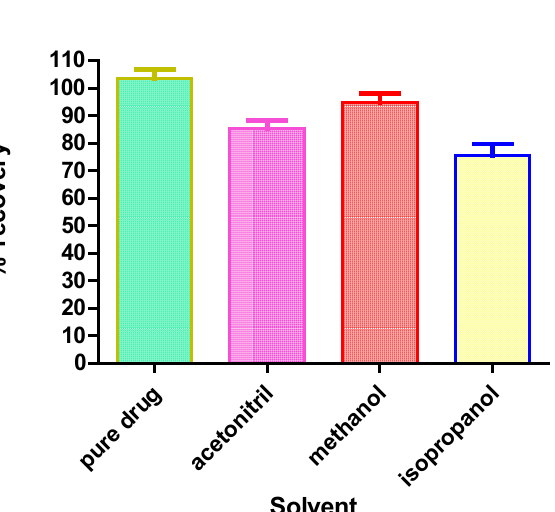
Figure 5: Effect of diluting solvent on the fluorescence intensity of DCV.